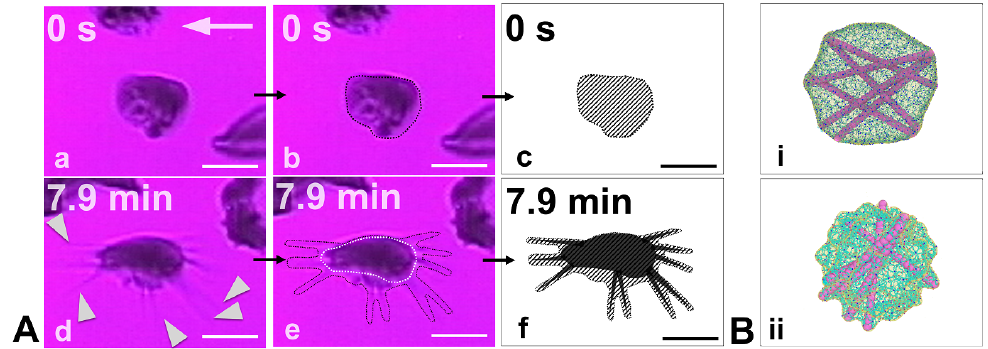
Figure 6. ( A ) Experimental results of simultaneous adhesion and polymerization in sickle reticulocytes under hypoxia and shear flow on a fibronectin-coated microchannel wall. ( a ) (t = 0) The cell adheres on the surface. ( d ) (t = 7.9 min) During cell adhesion, there is significant protrusion of polymerized HbS fibers (white pointers) outwards of the bulk of the cell. ( b , e ) Outline of the contours of the initial and final (including the HbS protrusions) snapshots of the adherent sickle reticulocyte. ( c , f ) Hatched sketches of the cell-wall contact area. The hatched area roughly represents the contact area of the cell’s lipid bilayer. The hatched area in snapshot ( c ) is approximately two times larger than the hatched area in snapshot ( f ). The white arrows denote the flow direction. Scale bar: 5 µ m. From Papageorgiou et al. [116] with permission. ( B ) Simulation results of HbS polymerization within a mature sickle cell ( i ) versus a sickle reticulocyte ( ii ). The excess membrane of the sickle reticulocyte in ( ii ) (that has